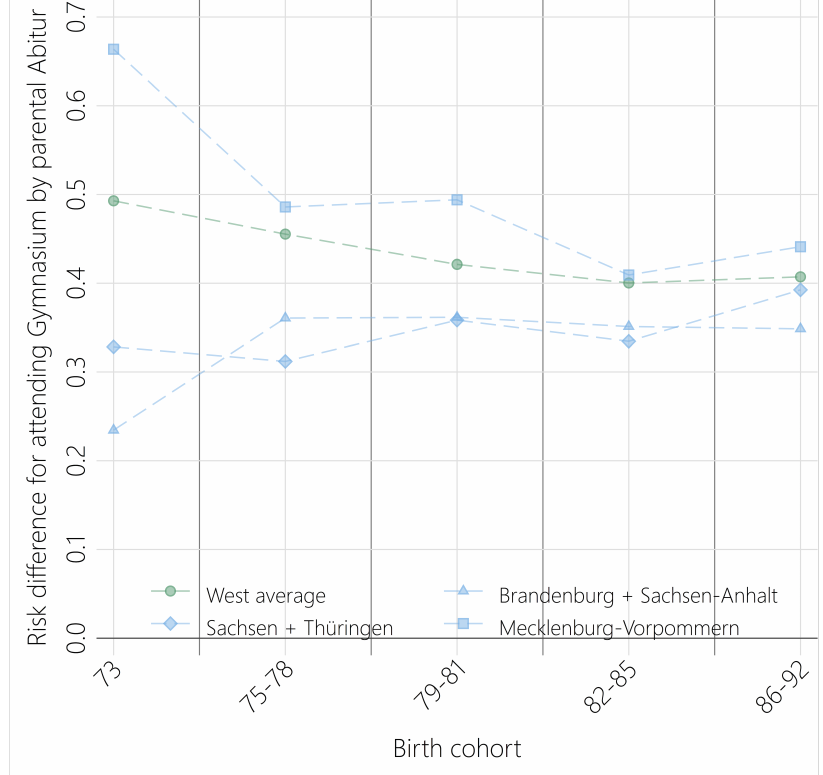
Figure 6: Change in IEO across birth cohorts in East German Länder and the West German average. Risk dif- ferences pertain to parental education. The first vertical line indicates the timing of reunification. Subsequent vertical lines differentiate birth cohorts according to the timing of educational transitions after